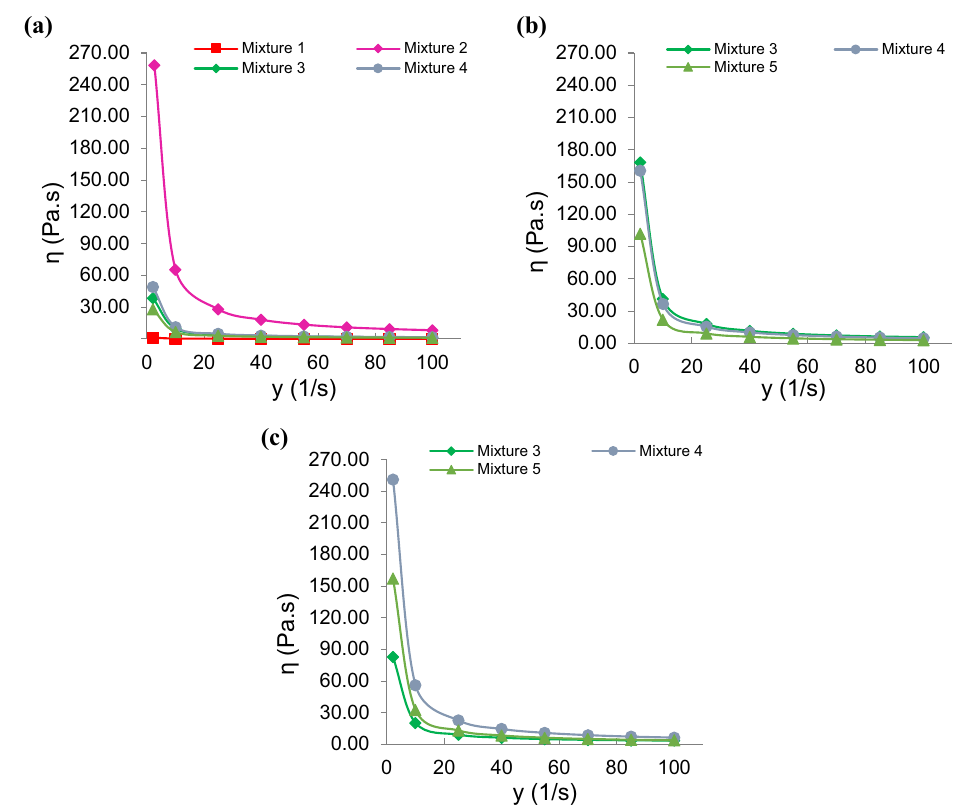
Figure 5: Apparent viscosity versus shear rate over time. ( a ) 0 h; ( b ) 24 h; and ( c ) 48 h.